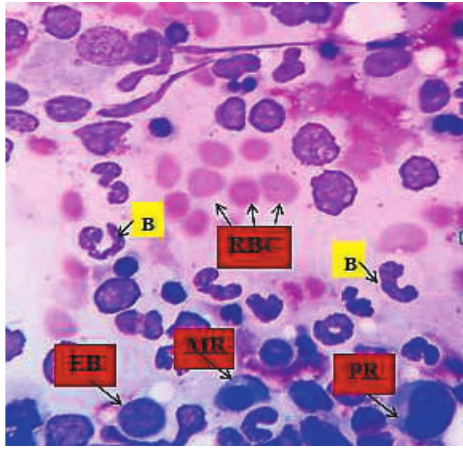
Fig. 7. Bone marrow cytological smear showing different myeloid and erythroid series of cells (Wright-Giemsa stain, 1000x). MB- Myeloblast; PM – Promyelocyte; M – Myelocyte; MM – Metamyelocyte; B- Band cells; PMN- Matured segmented neutrophil; PR – Prorubricyte; PE- Polychromatophilic erythrocyte; MR-